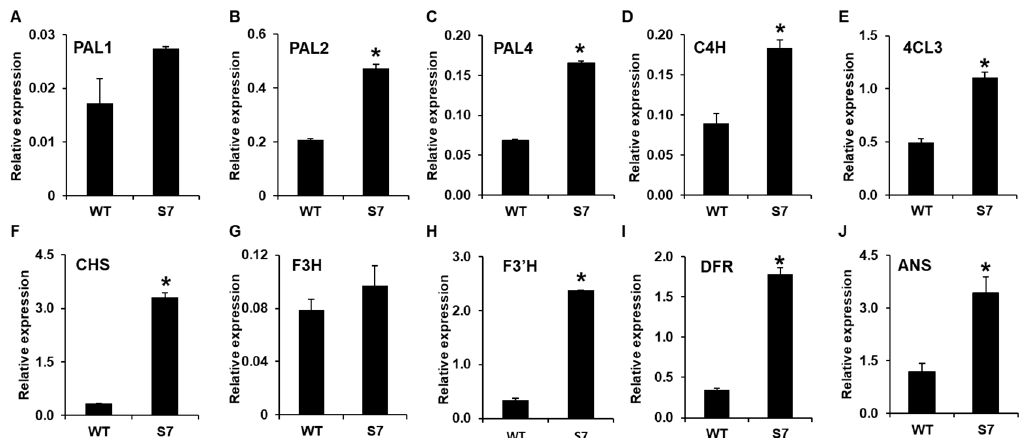
Figure 5. qRT-PCR analysis of 10 genes showing altered expression levels in the RNA sequencing (RNA-Seq) analysis. The genes were associated with anthocyanin biosynthesis. More specifically, A – J indicate the relative expression levels of PAL1 , PAL2 , PAL3 , C4H , 4CL , CHS , F3H , F3 ′ H , DFR , and ANS , respectively. The elongation factor 1-alpha ( EF1a ) gene served as an internal control. Error bars indicate standard deviations ( n = 3). The experiment was repeated three times with similar results. Asterisks denote a significant difference between respective WT and RB016-S7 mutant leaves samples ( t -text, P < 0.0001).